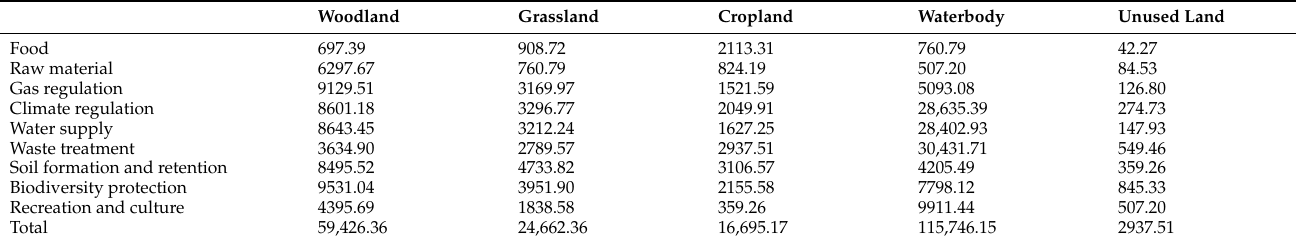
Table 1. Ecosystem service value per unit of land-use type in the PRD (CNY/hm 2 ). Woodland Grassland Cropland Waterbody Unused Land Food 697.39